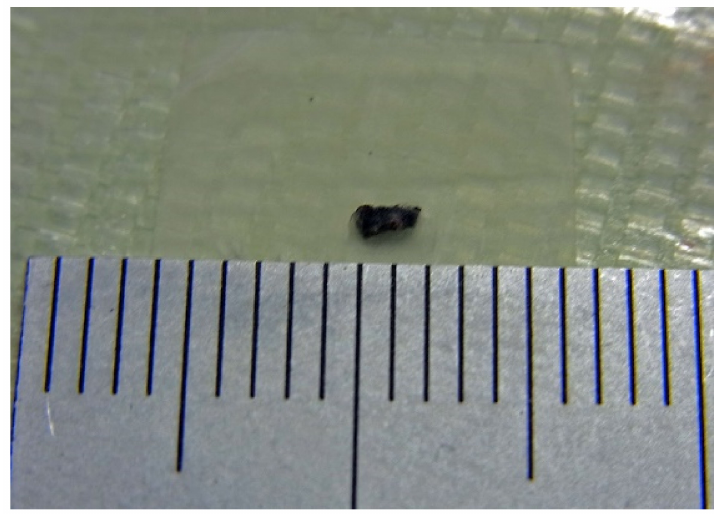
Figure 14. Photograph of the measured small steel